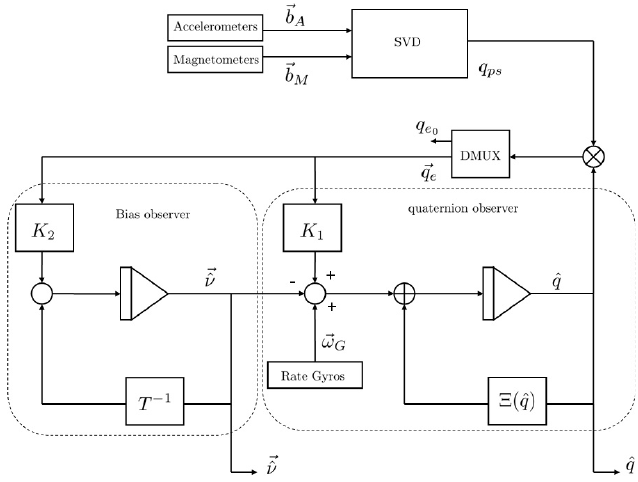
Figure 1. Block diagram of the nonlinear observer ( ⊗ quaternion multiplication, ⊕ matrix